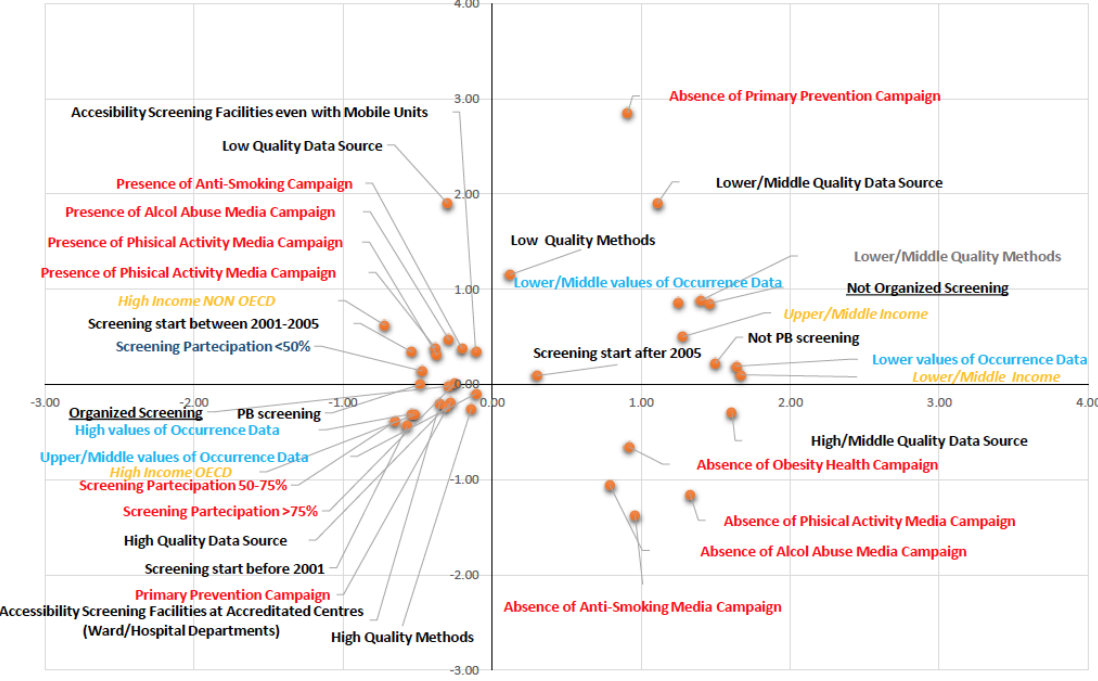
Figure 2. Results of multiple correspondence analysis.